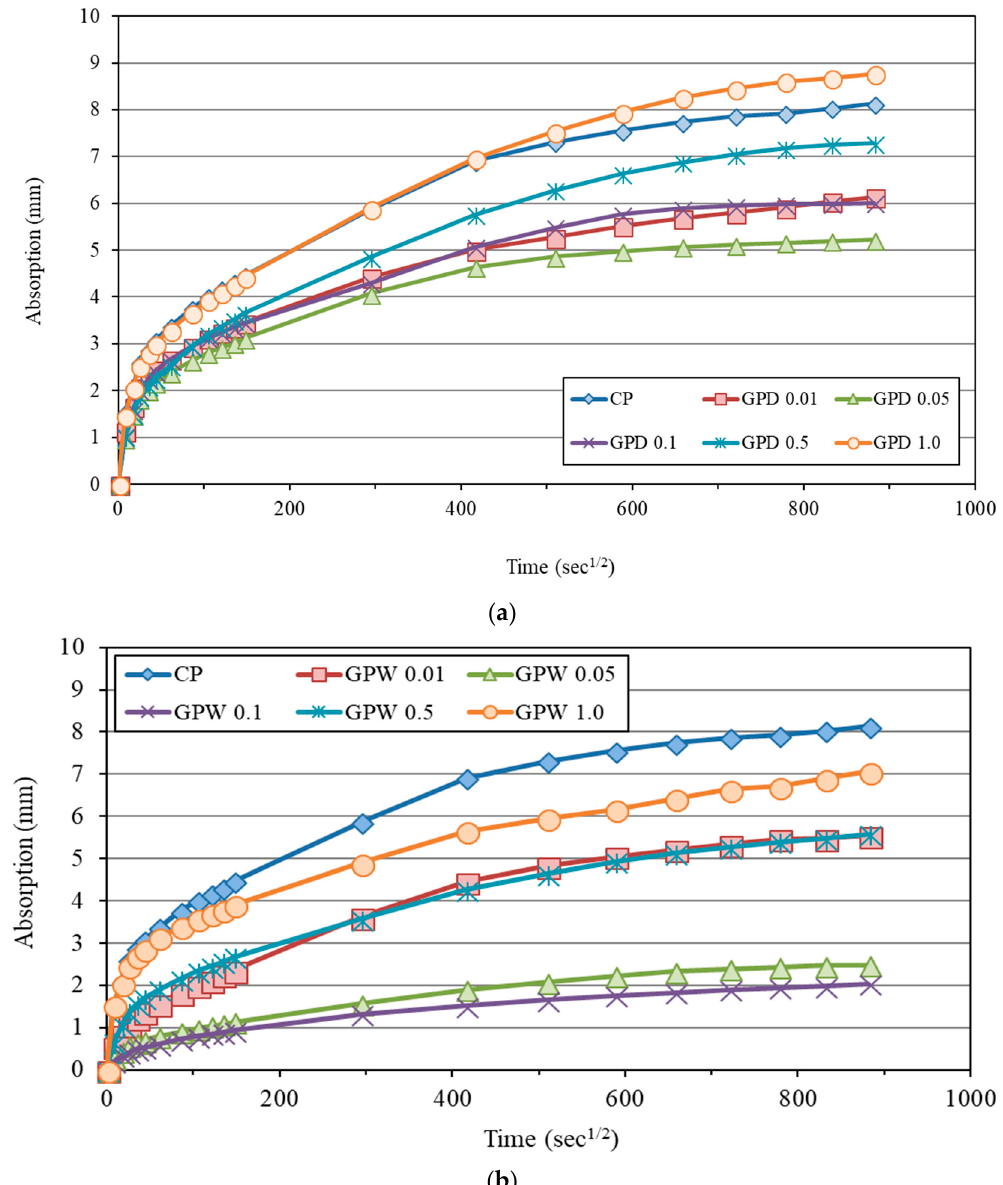
Figure 13. Water sorptivity of EOGO-cement pastes: ( a ) Dry-mix design and ( b ) wet-mix design.